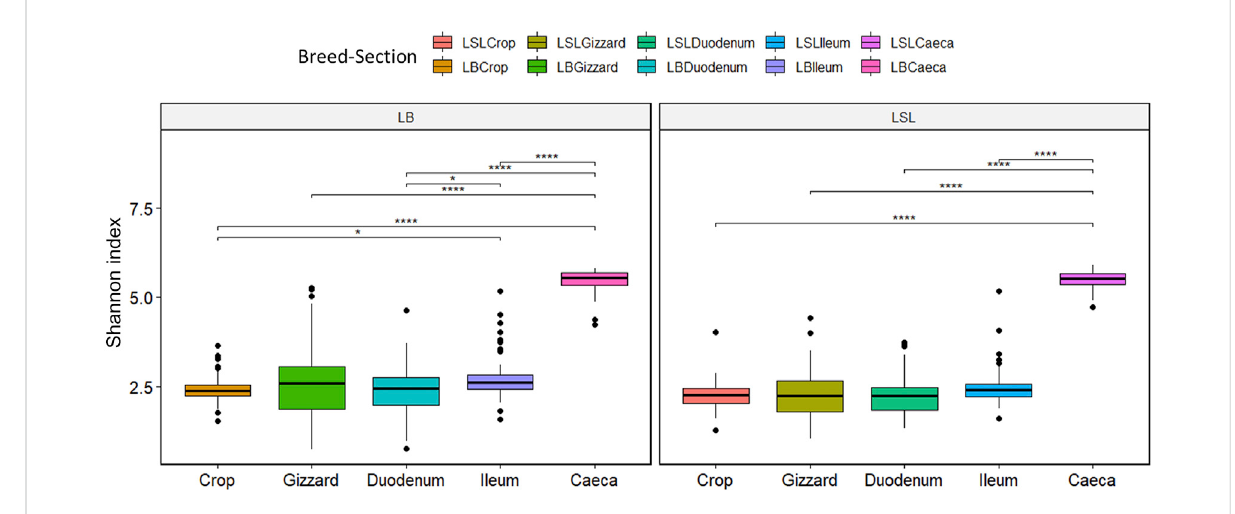
FIGURE 3 Boxplot of Shannon diversity index separated by the breed, section (color) and Ca/P combination of the diet (* p < 0.02; **** p <